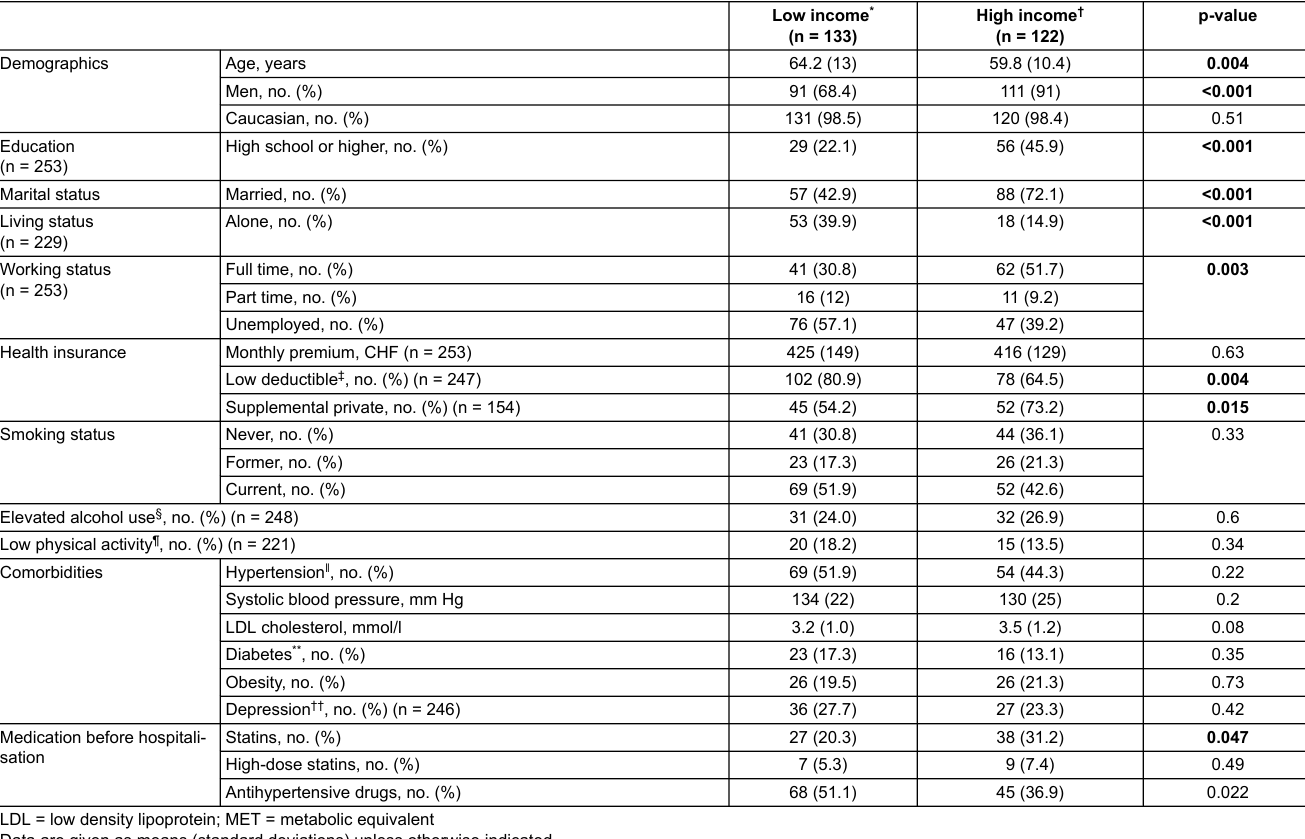
Table 1: Baseline characteristics by household income status (n =